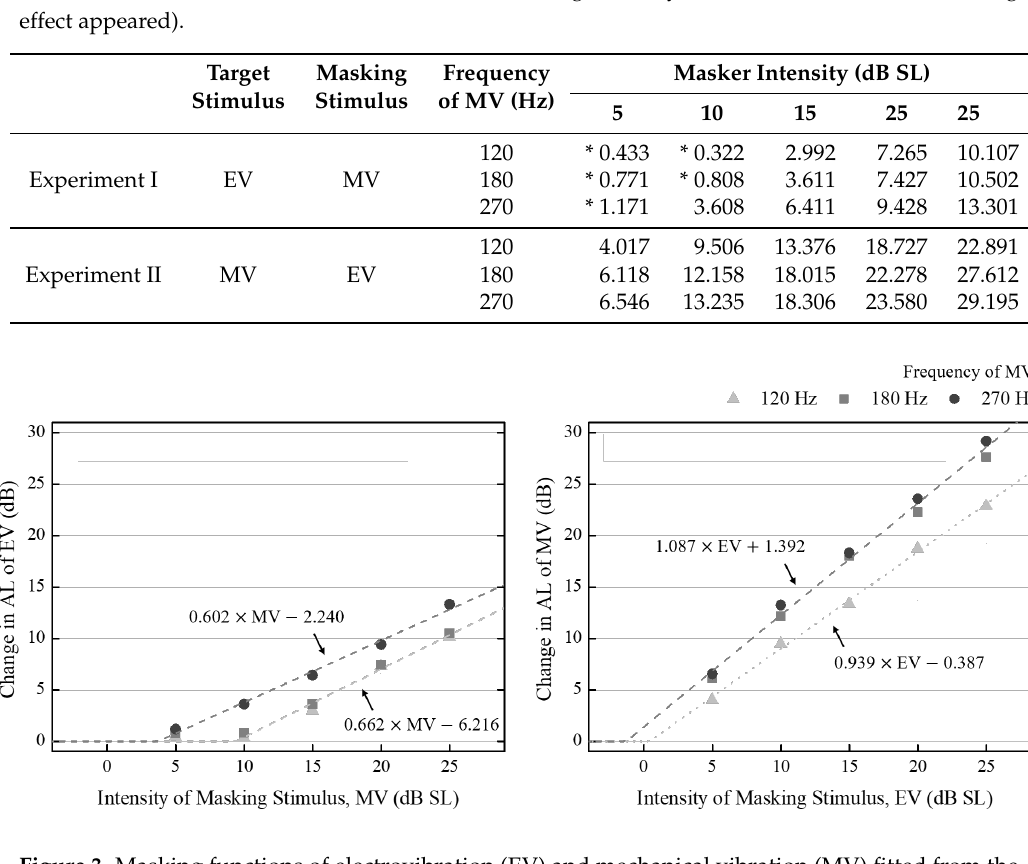
Figure 3. Masking functions of electrovibration (EV) and mechanical vibration (MV) fitted from the results in Table 2. AL, absolute threshold; SL, sensation